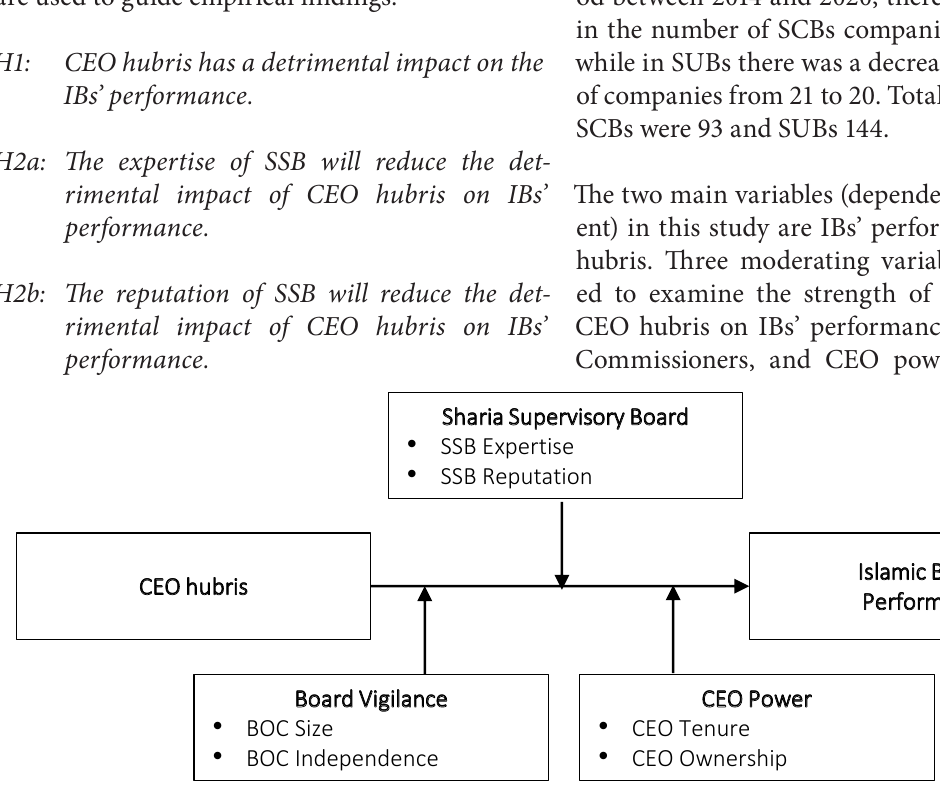
Figure 1. Conceptual framework: Interaction between moderating and independent variables on IBs’